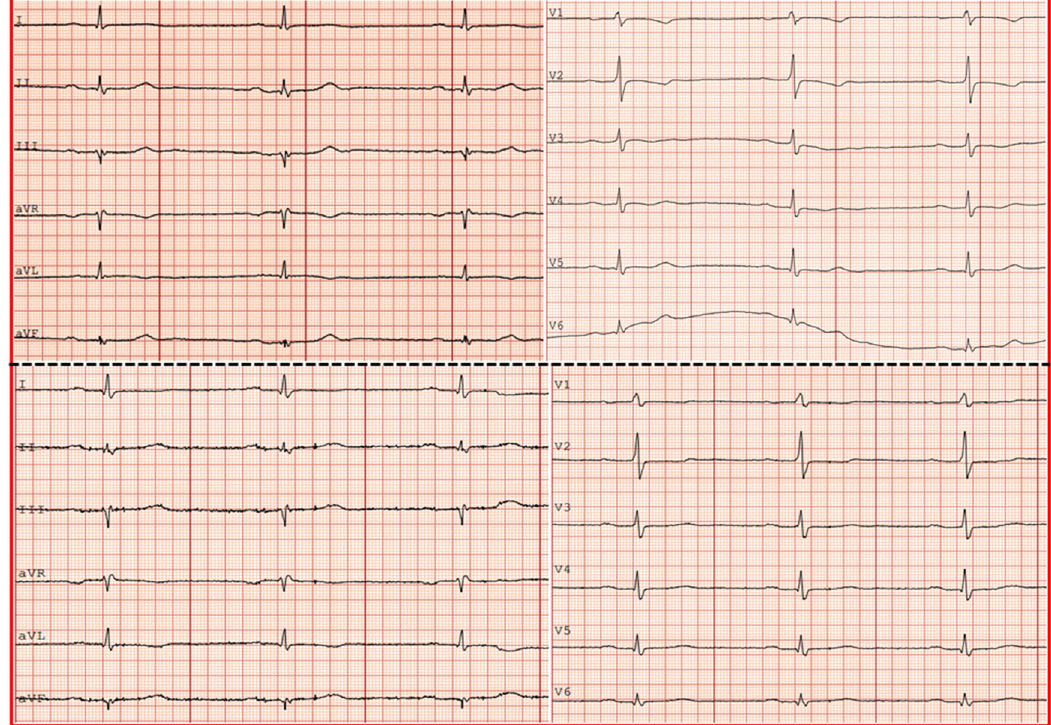
Figure 1. Electrocardiogram on admission (upper panel) showing sinus rhythm and T-wave inversion in leads V1–V4 and AVL. Electrocardiogram at discharge (lower panel) showing sinus rhythm and regression of the T-wave inversion in leads V1–V4.